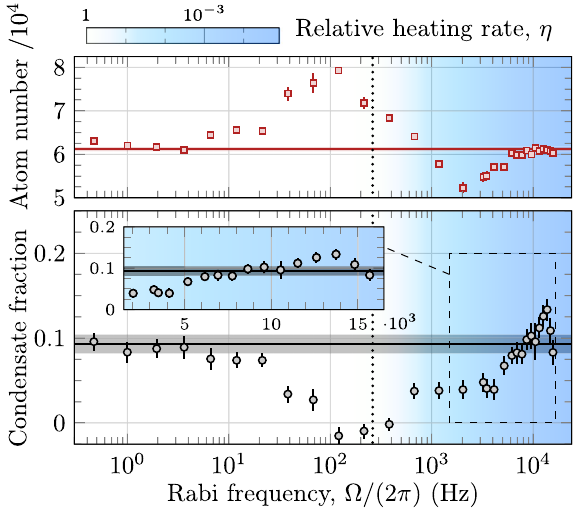
FIG. 6. Condensate fraction and total atom number at unitarity as a function of the driving frequency. At very low frequencies, the spin oscillation is slow enough such that both observables are the same as without the driving, which are marked by horizontal lines with shading representing the uncertainty. At higher frequencies, the driving has an adverse effect on the superfluid. The vertical dashed line marks the frequency at which η ¼ 1 [see Eq. (17)]. Above it, heating starts to be suppressed (the color represents the value of η ). At even higher frequencies, the atom number returns to its initial value, and the condensate fraction reaches an even higher value than for a stationary gas (inset). The conditions are measured after 5 ms at the Feshbach resonance magnetic field, and the Rabi frequency is varied by changing the rf pulse power. The observables extraction procedure is discussed in Appendix B. The error bars combine the 1 σ mean confidence interval of the fit with statistical errors over ten repetitions.